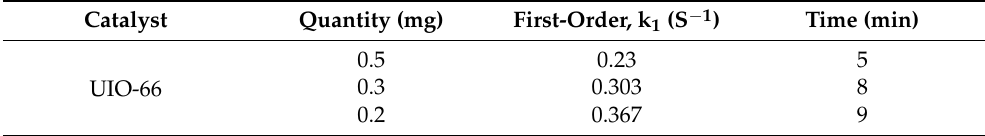
Figure 10. Pseudo first-order linear fitting to the intensity of the time variant UV-Vis spectra, obtained throughout the catalytic reduction of 4-NP to 4-AP. Table 1. The rate constant values at different UiO ‐ 66 catalyst concentrations.